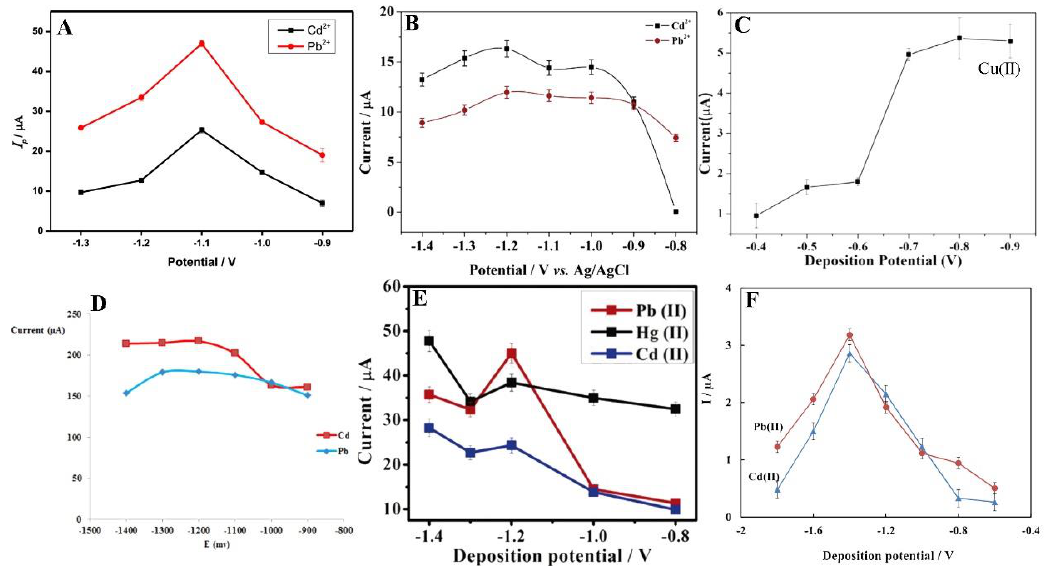
Figure 4. Optimisation of deposition potential used in electrochemical determination of different ions such as Cd 2+ , Pb 2+ , and Hg 2+ presented by Pu et al. [61] ( A ), Xu et al. [63] ( B ), Wei et al. [55] ( C ), Dahaghin et al. [66] ( D ), Deshmukh et al. [68] ( E ), and Baghayeri et al. [69] ( F ) . All Figures are adapted from references [55,61,63,66,68,69] with permission from Elsevier.